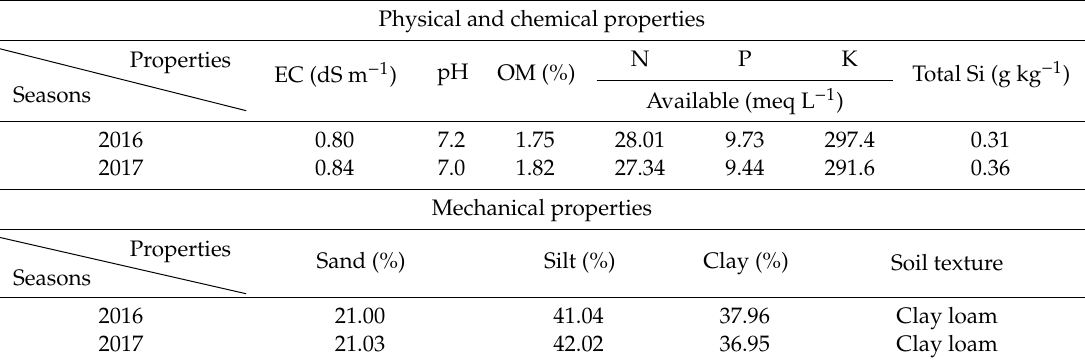
Table 1. Analysis of investigated experimental soil before sowing in 2016 and 2017